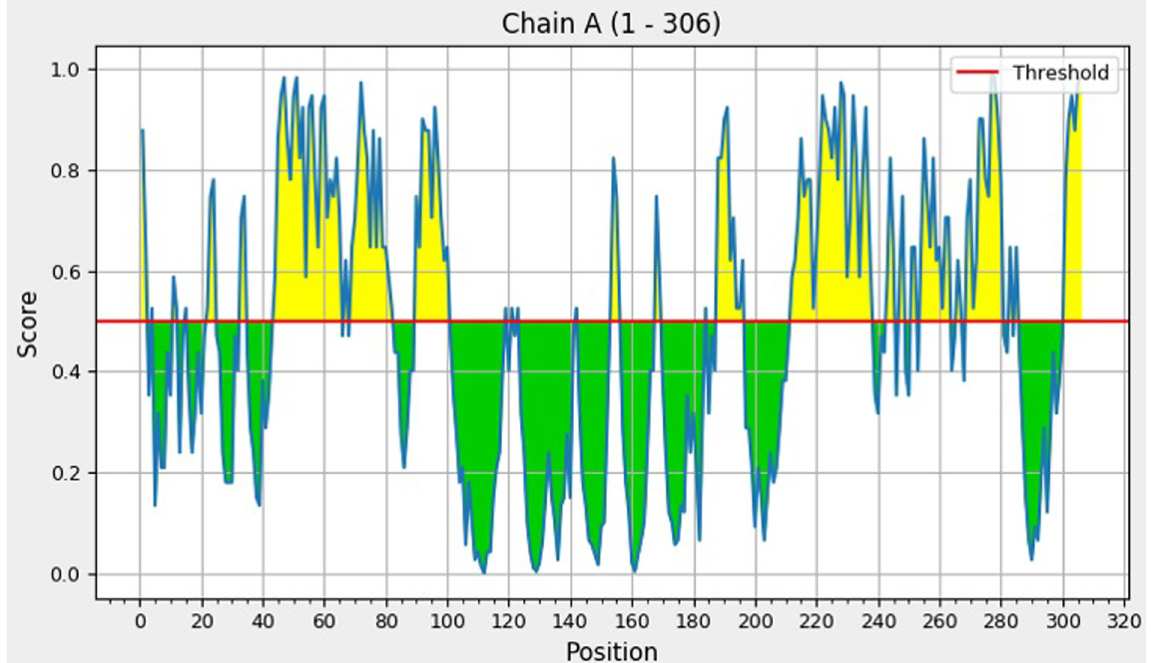
Fig 2. The probability of a residue surface influenced by accessibility to surfaces, surface flexibility, Parker’s hydrophilicity, and antigenicity predictions of non-structural protein (PDB 6M2N) determined by IEDB Parker hydrophilicity prediction has a maximum score of 5.329, ranging from 92 to 98, with the heptapeptide sequence 92 DTANPKT 48, and a minimum value of -4.257, ranging from 204 to 210, with the VLAWLYA sequence of the peptide.